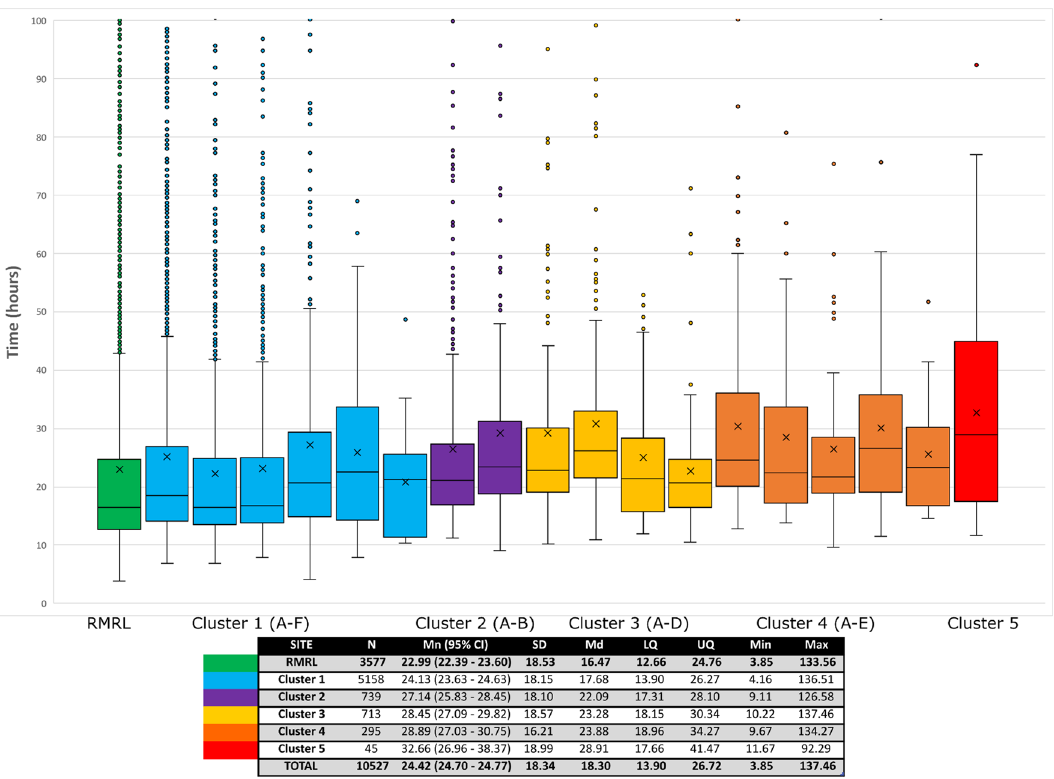
Figure 3. Distribution of total detection time (TDT) (h) per sites, showing interquartile ranges. Data points between 0 and 100 h are represented on the figure. Outlier points as per the 1.5 × IQR rule are included on the graphic. X: mean. Inset: mean TDT for all sites clusters along with standard deviation, median and lower/upper quartile. N: number of samples, Mn: mean, CI: confidence interval, SD: standard deviation, Md: median, LQ: lower quartile, UQ: upper quartile, Min: minimum, Max: